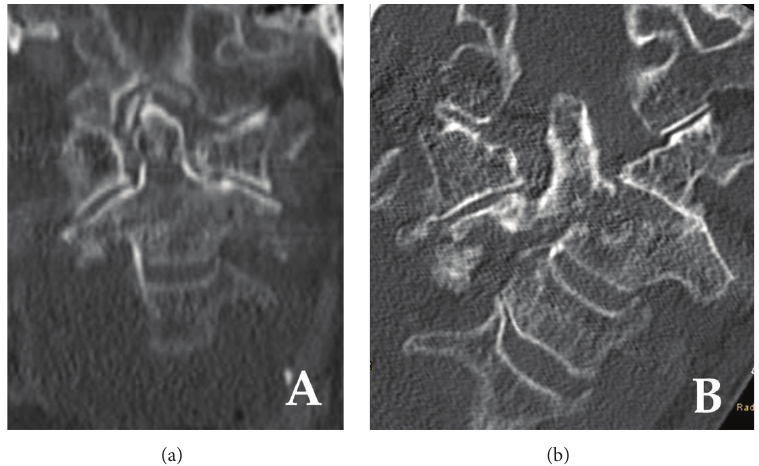
Figure 1: Coronal plane cervical spine computed tomography (CT) images of a 90-year-old woman. (a) Initial imaging showing minimal displacement and good cancellous bony contact and the typical oblique fracture pattern. (b) Follow-up imaging after 6 weeks of collar immobilization showing severe lateral displacement and tilting with dislocation of the left C1/2 facet